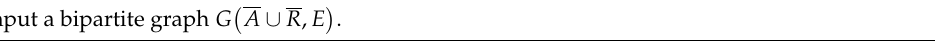
Algorithm 3. Decomposition of a DAE component.